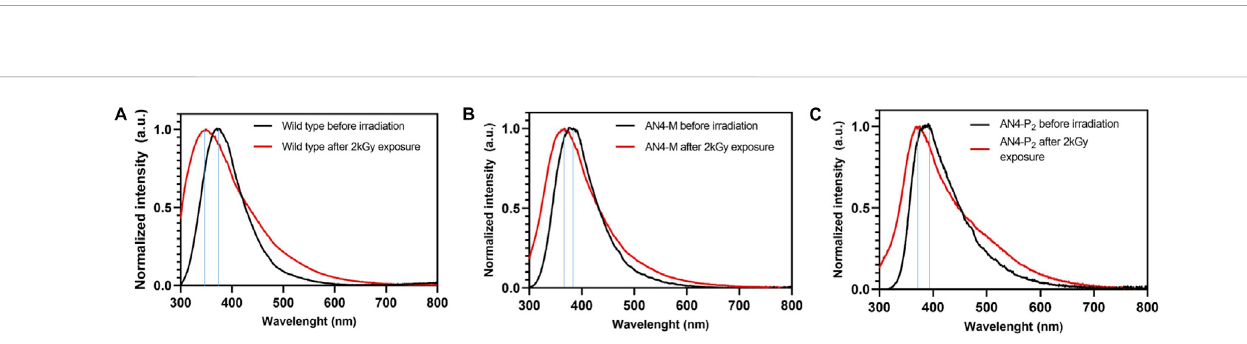
FIGURE 6 ESR spectraof wild type, AN4-M (A) and AN4-P 2 fruits (B) at2 kGy absorbed dose (doserate = 1.8 kGy/h). The intensity of each signal isexpressed as the peak-to-peak height normalized for mass unit and by subtracting the intensities of the signals before irradiation.